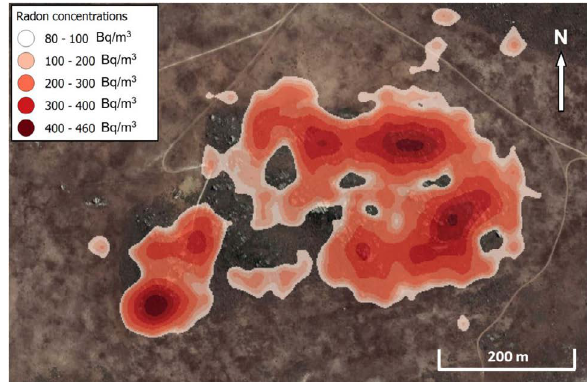
Heat map of the estimated radon potential overlaid on a Google Earth image of Baviaansberg.